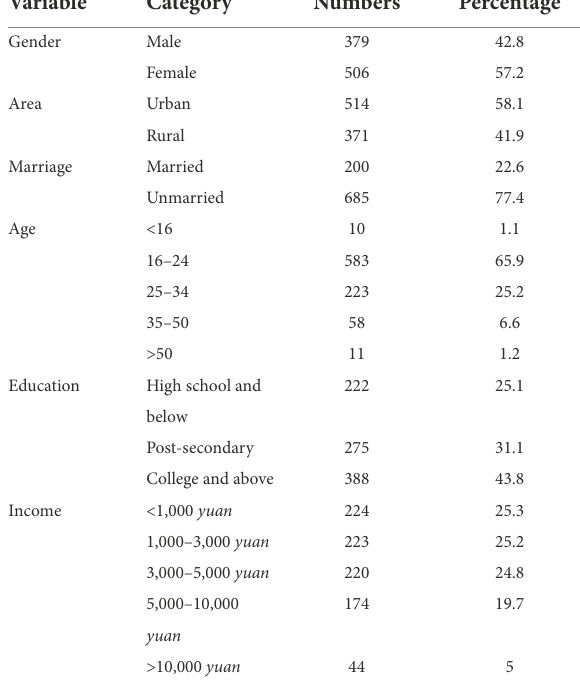
TABLE 1 Demographic information ( N =